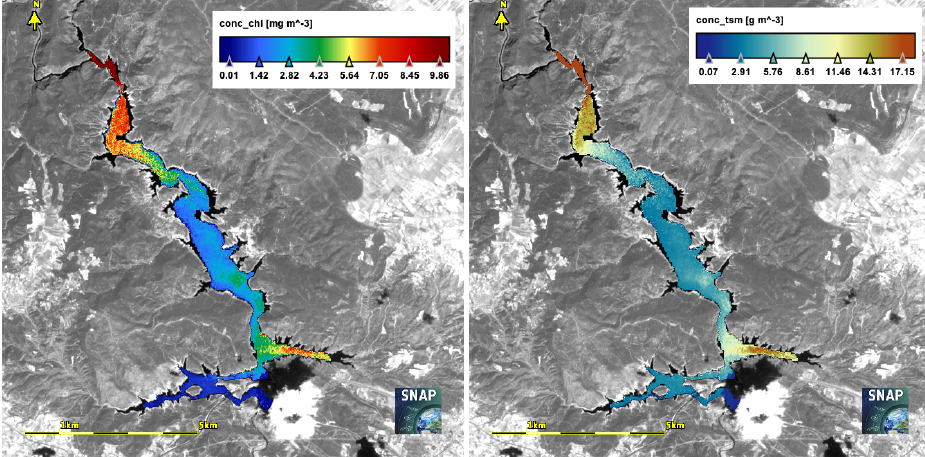
Figure 5. Ch-a and TSM concentration derived on the 11 May 2019 in the Contreras